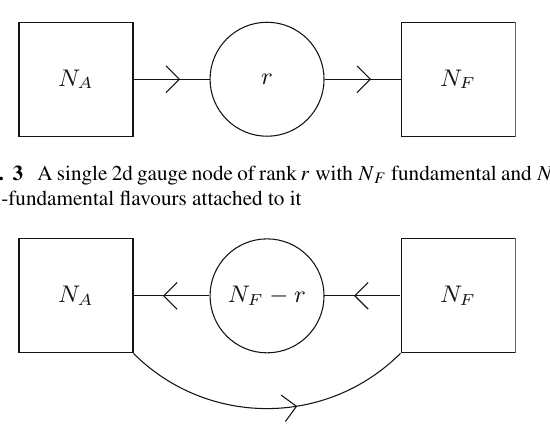
Fig. 4 The theory obtained after a 2d Seiberg duality on the gauge node in Fig. 3 W A = 2 π i τ Tr σ . cl